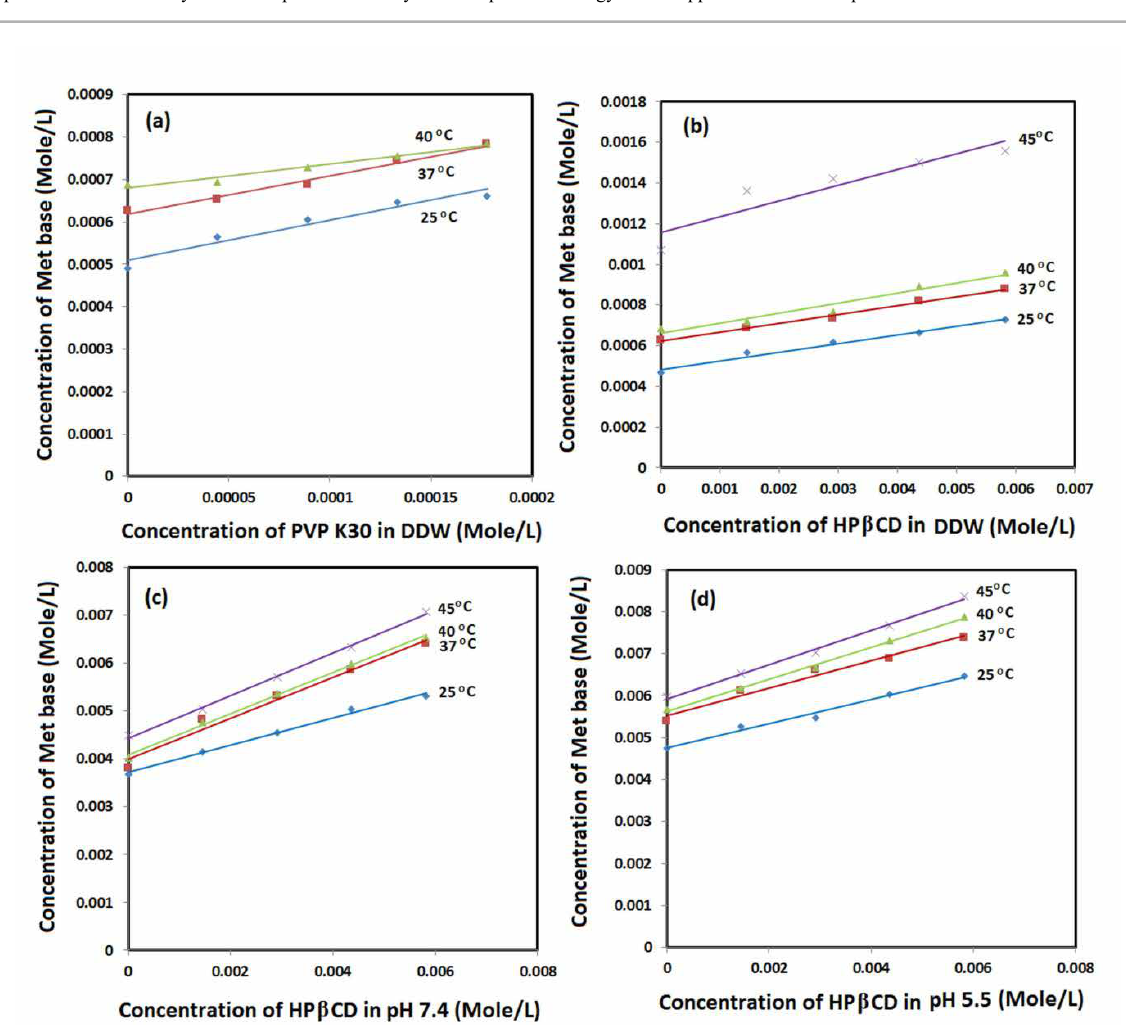
FIGURE 1 – Phase solubility diagram of Met base at different temperatures: (a) in presence of DDW and PVP K30; (b) in presence of DDW and HPβCD; (c) in presence of pH 7.4 and HPβCD; (d) in presence of pH 5.5 and HPβCD.